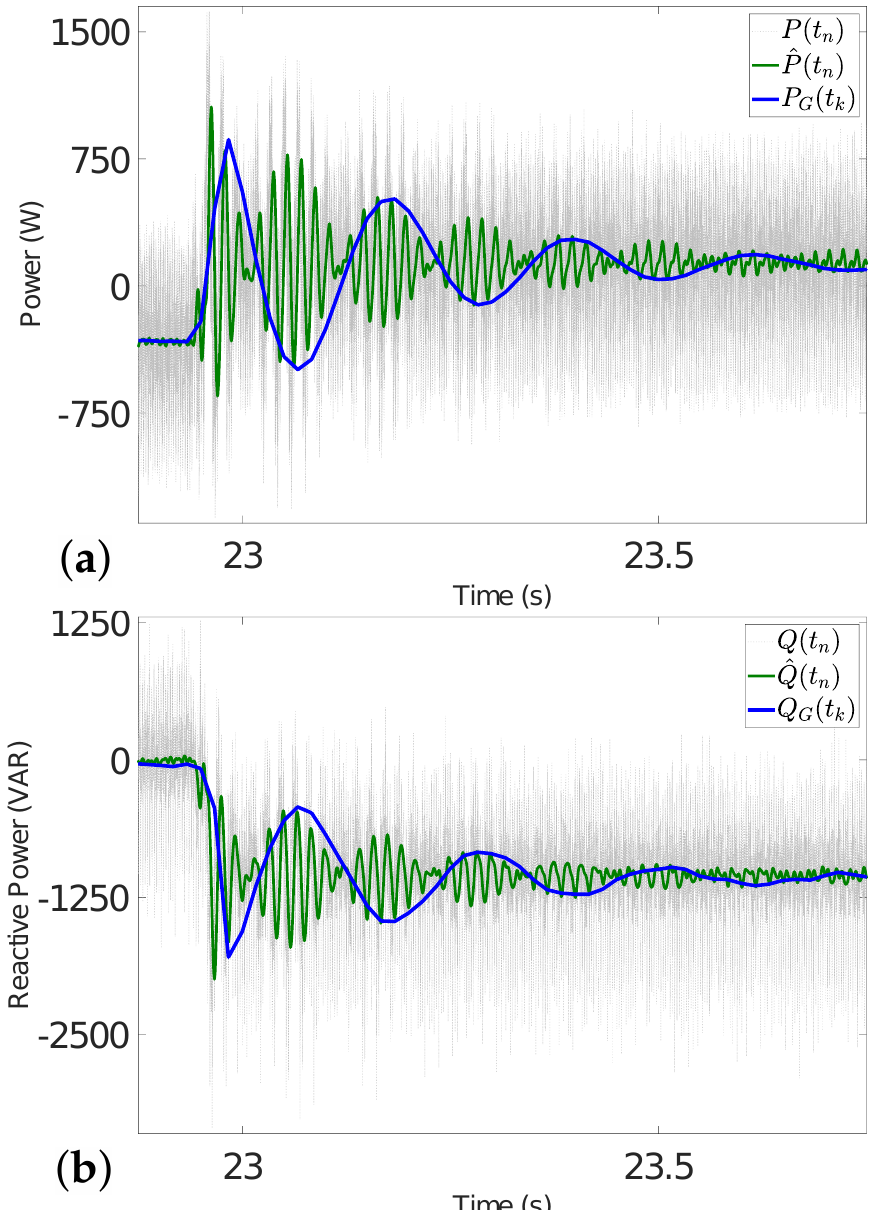
Figure 11. GOLD method actual performance, illustrating both ( a ) real and ( b ) reactive power disturbance